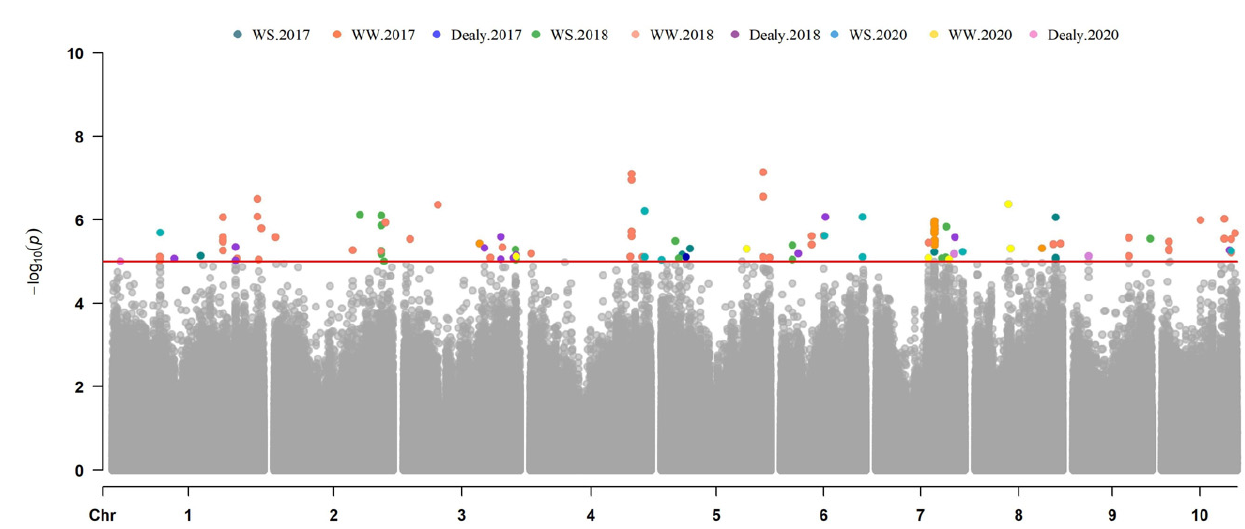
Figure 4. Manhattan plots of ear biomass using MLM model in three years.